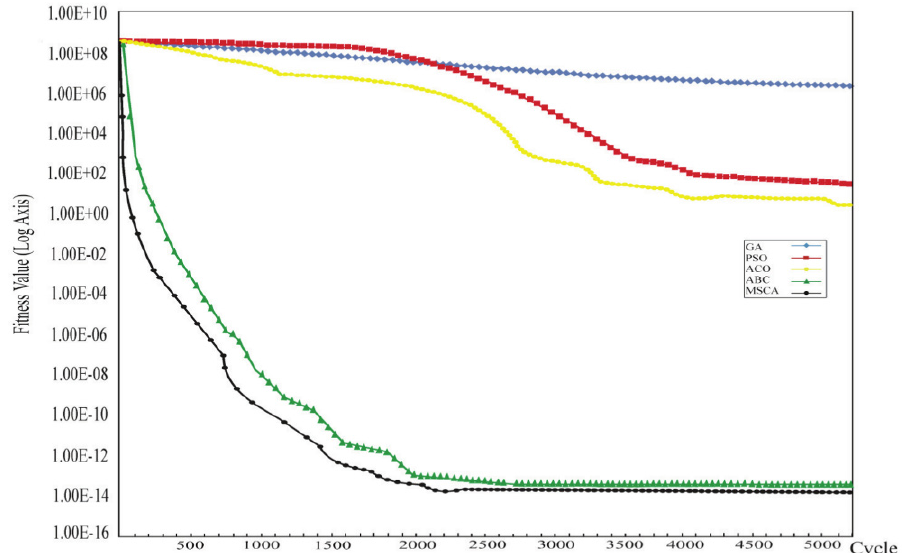
Figure 5. The results of applying different algorithms on Griewank